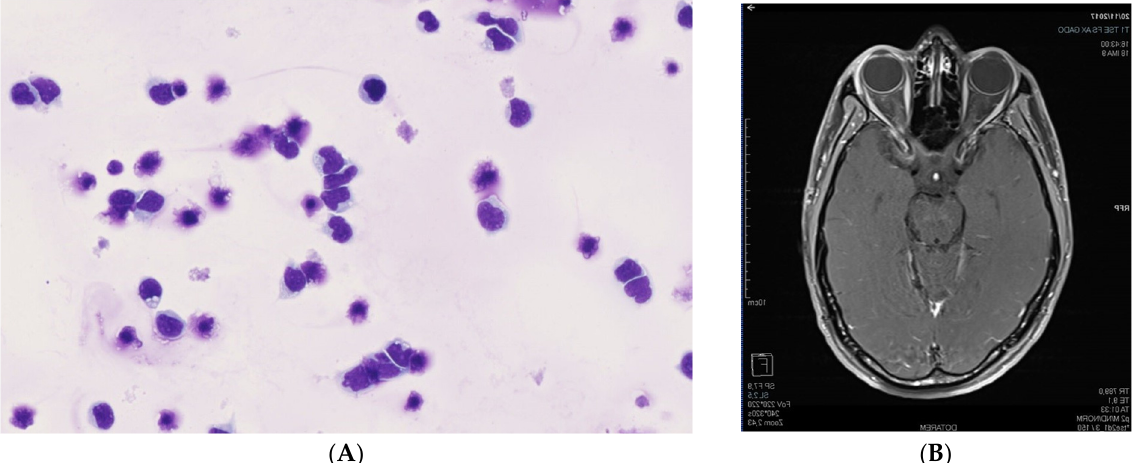
Figure 5. Case 5. ( A ) Anterior chamber aspiration; High-power view shows the blast cells in the anterior aqueous humour sample (May-Grünwald-Giemsa staining); ( B ) Brain MRI; Axial postcontrast fat-suppressed T1-weighted image passing through the orbits and the brain, showing enhancement of the ciliary processes of the left eyeball associated with abnormal enhancements of the dorsal pre-and extraconal post-septal spaces.